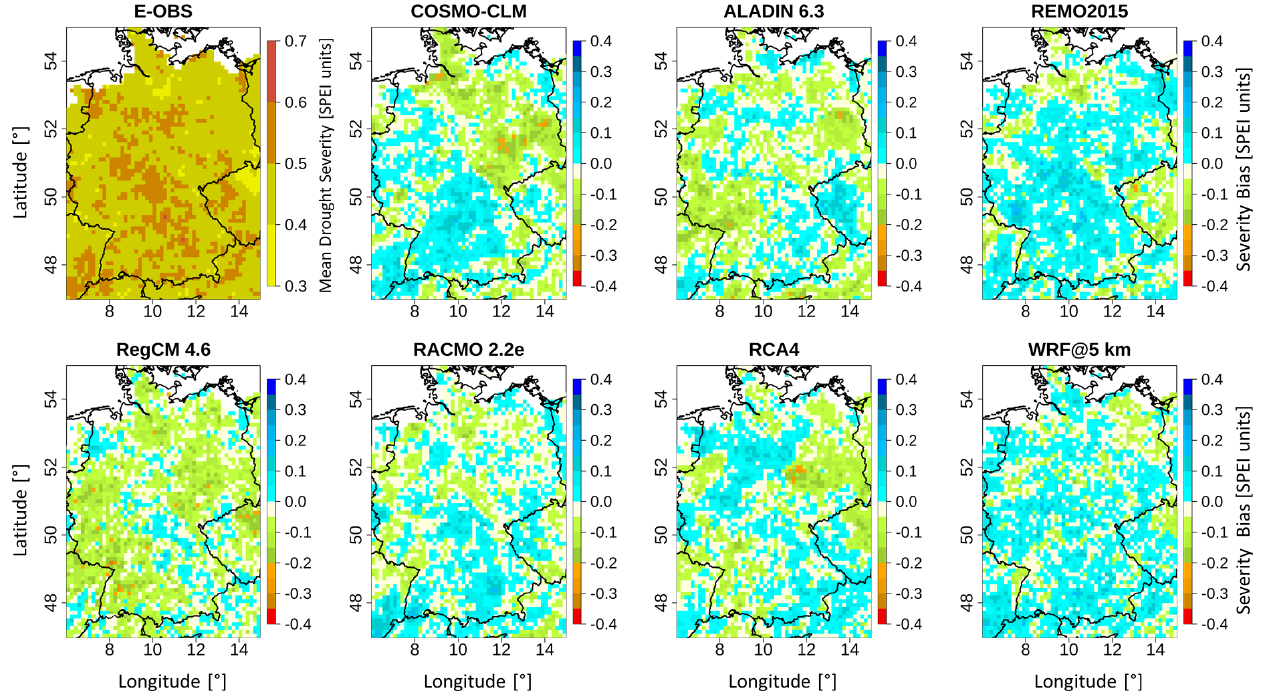
Figure 8. Grid-cell-based E-OBS mean drought severity pattern based on SPEI-3 between 1980–2009 and differences between each RCM and